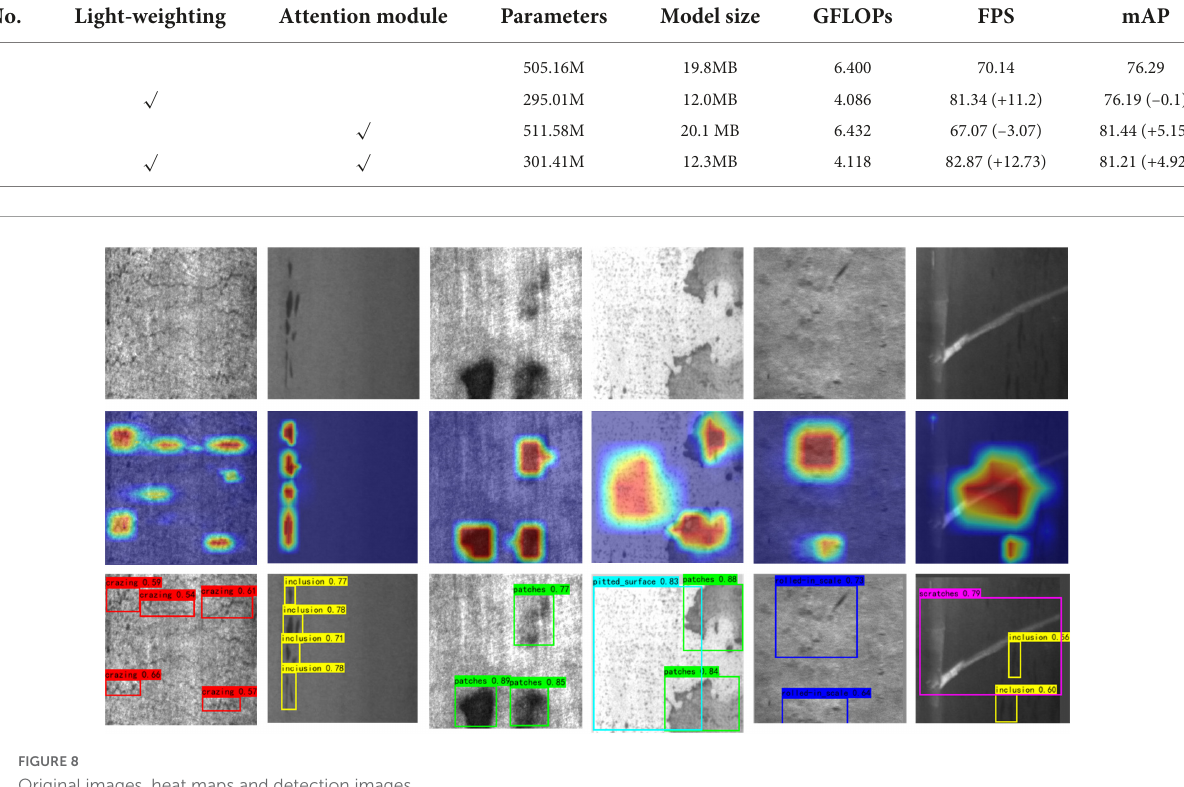
FIGURE8 Original images, heat maps and detection images.